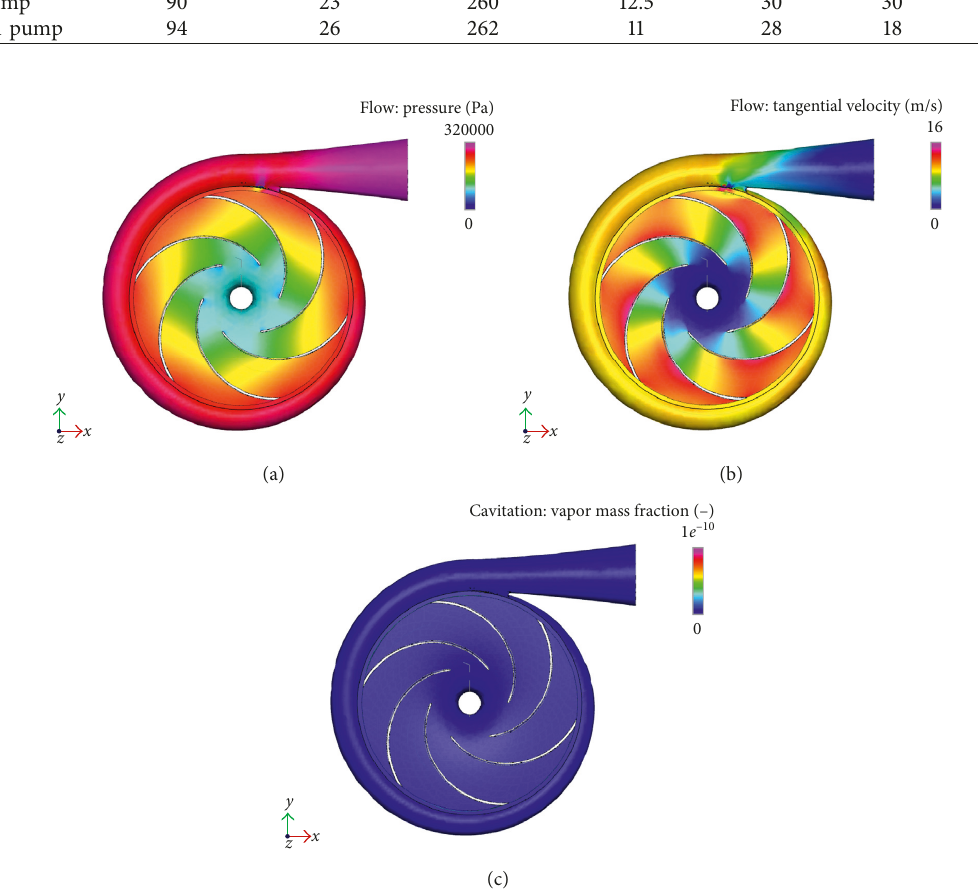
Figure 6: Optimization pump flow field simulation. (a) Optimized pressure contour diagram. (b) Optimized velocity contour diagram. (c) Optimized cavitation contour